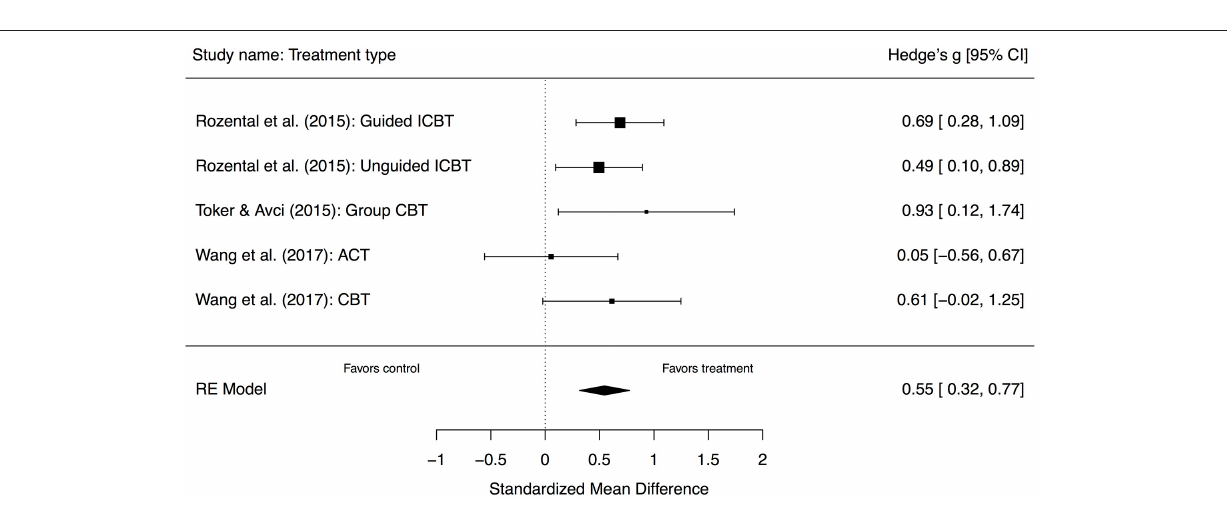
FIGURE 3 | Forest plot displaying the effect sizes of studies comparing cognitive behavior therapy with inactive comparators. RE, random effects; CI, confidence interval.